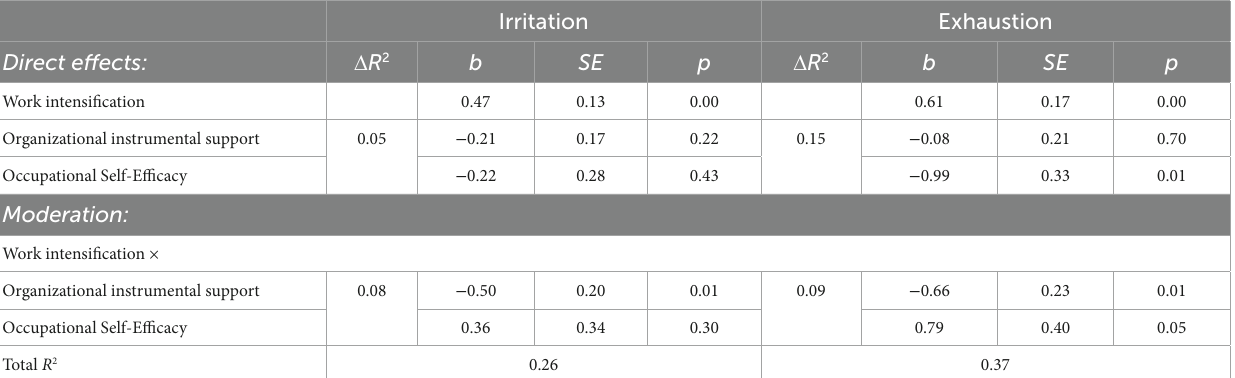
TABLE 3 Regression analyses work intensification.